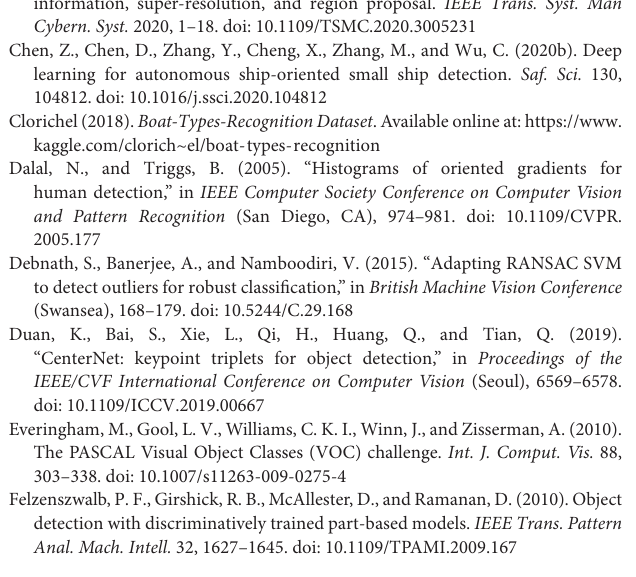
Boat-types-recognition